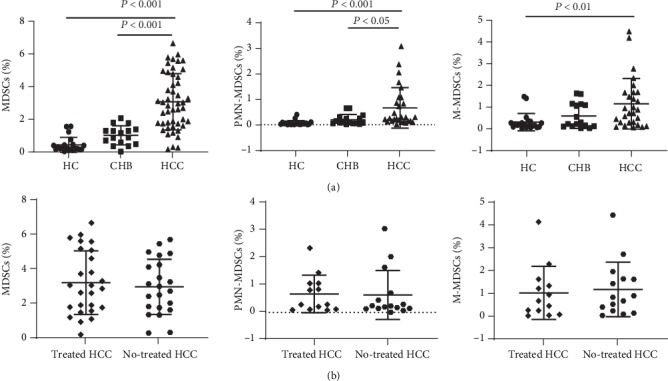
Frequency of circulating MDSCs in study subjects. (a) Frequency of MDSCs, PMN-MDSCs, and M-MDSCs in HCC patients, CHB patients, and healthy controls. (b) Frequency of MDSCs, PMN-MDSCs, and M-MDSCs in HCC patients who received and did not receive anti-HBV therapy.